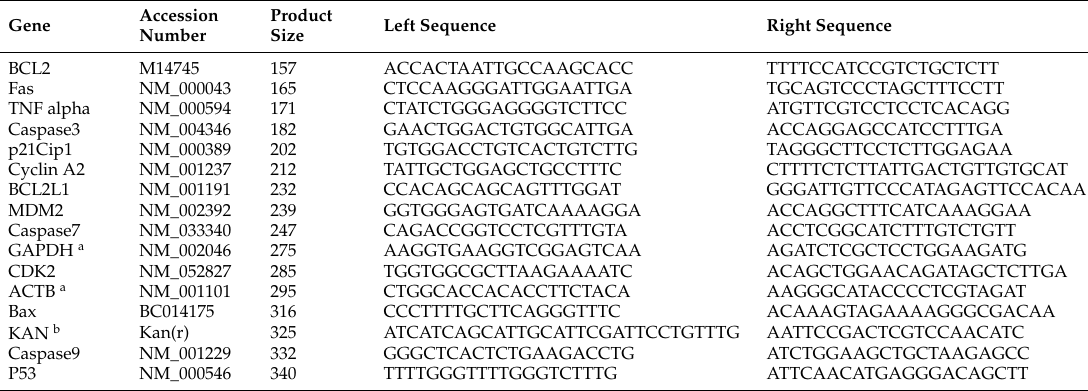
Table 1. Details of the primer sequences used in GeXP